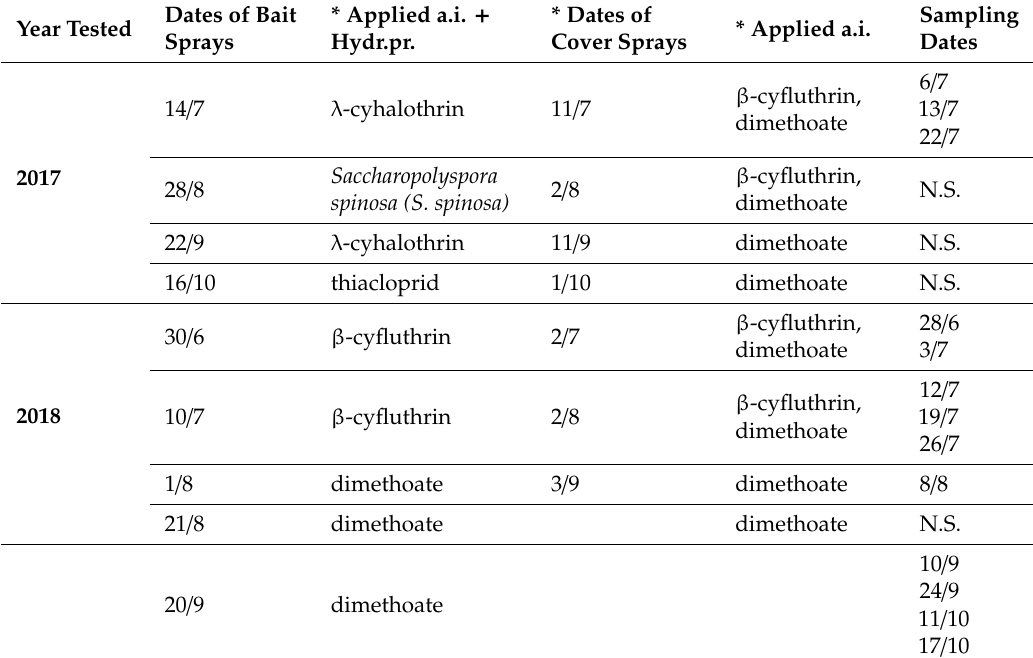
Figure 1. Experimental orchards of Spilia and Astrikas region from where bee samples were taken during 2017 (yellow marks) and 2018 (red marks). CS: orchard treated by cover sprays, BS: orchards treated by Bait sprays and UN: Unsprayed orchard. Table 1. Treatments and dates of bait and cover spray applications and possible applied active ingredients from 2017 to 2018 as well as bee sampling